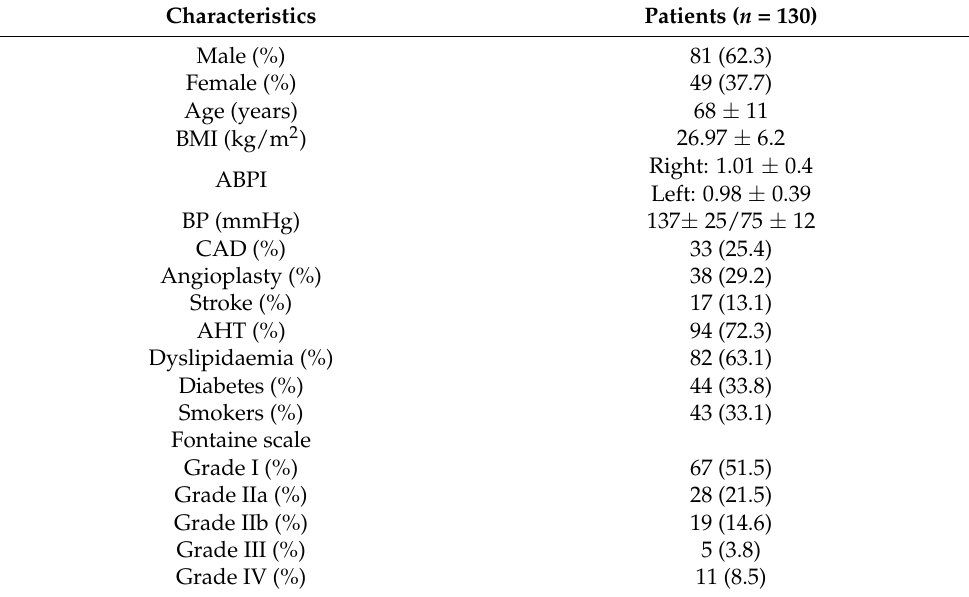
Table 1. Patient characteristics.